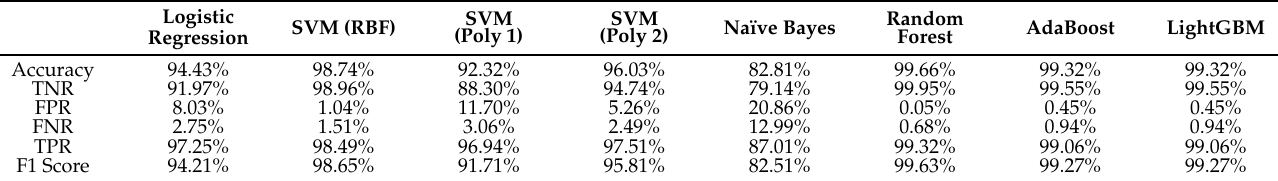
Table 2. Performance of the tested models on the non-evasive validation